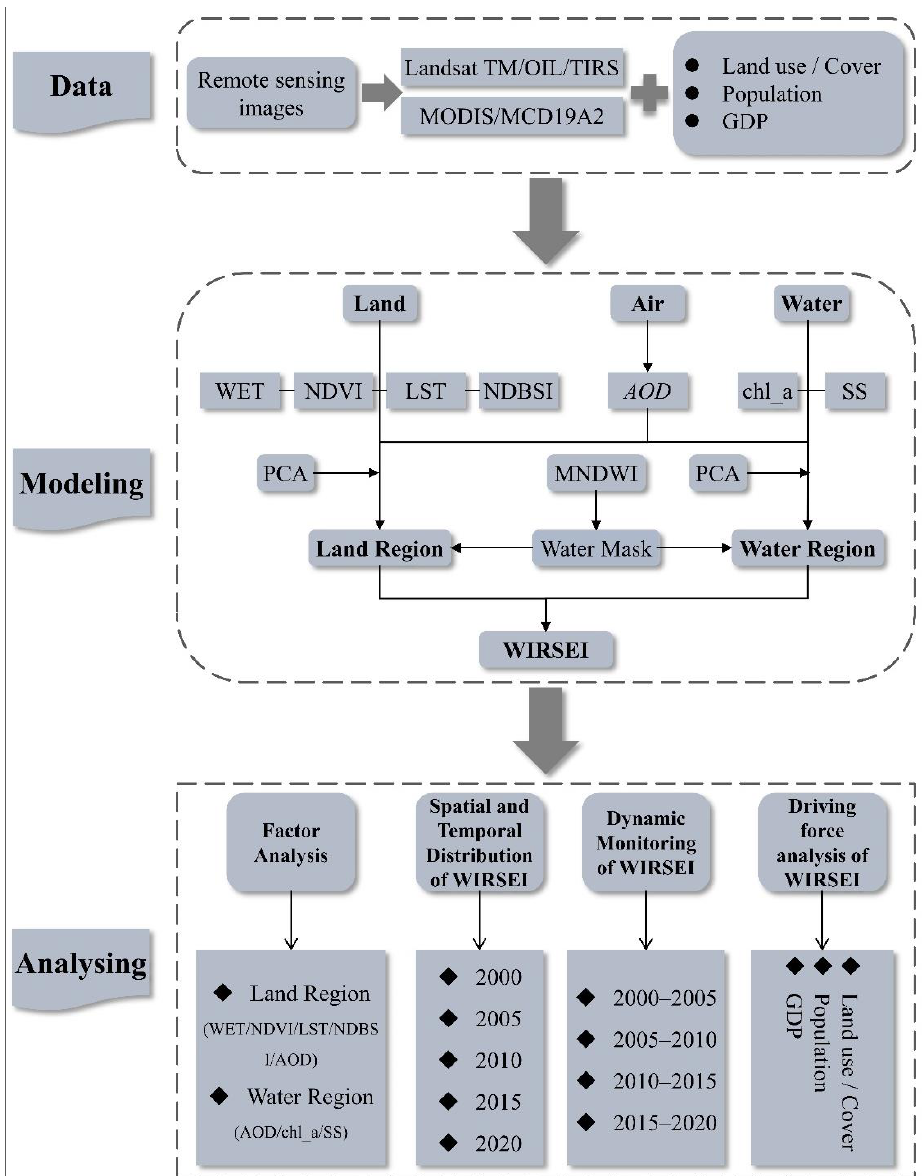
Figure 2. Overall methodological